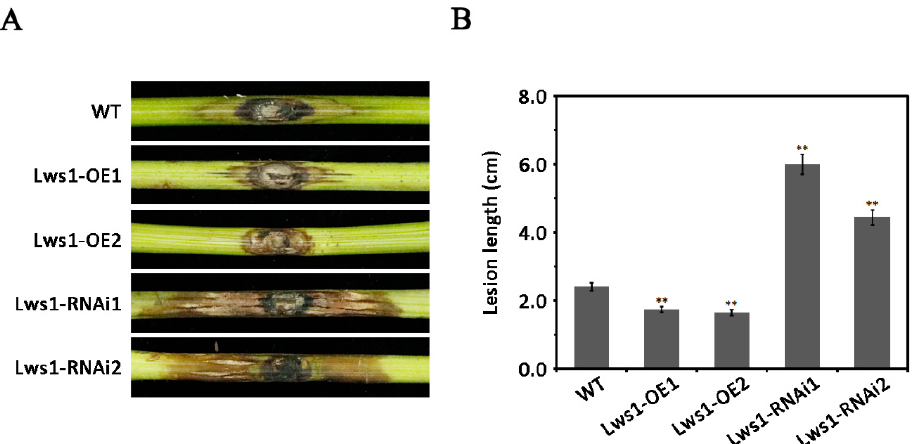
Figure 2. Regulation of Lws1 in the virulence of L. theobromae . ( A ) Pathogenicity tests of the wild type (WT), overexpressed transformants (Lws1-OE1 and Lws1-OE2), and silenced transformants (Lws1-RNAi1 and Lws1-RNAi2). Mycelial plugs of these strains (5 mm in diameter) were inoculated on susceptible grapevine green shoots and then placed inside a chamber with constant humidity and temperature. Images were photographed at 3 days post-inoculation (dpi). ( B ) Comparison of the lesion length caused by the strains mentioned in ( A ). The lesion lengths of these strains were quantified at 3 dpi. At least five biological replicates of each strain were tested. A representative set of data is presented. Statistically significant differences are marked by asterisks and were evaluated using one-way analysis of variance (ANOVA) and least significant difference (LSD) tests. ** α = 0.01.